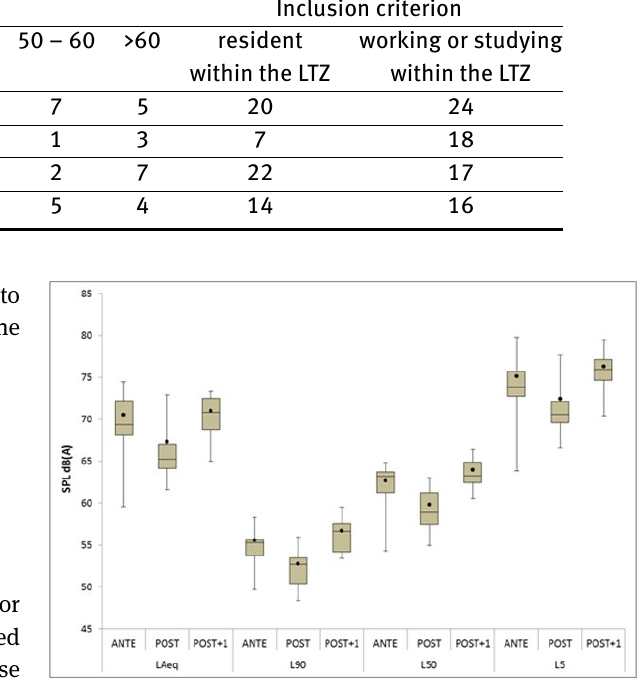
Figure 3: Noise levels distributions of the ten selected for the ANTE , POST and POST + 1